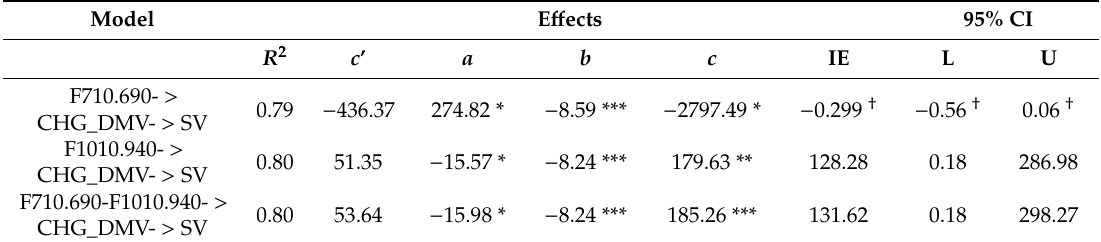
Table 2. Outcomes of mediation analyses from F710.690, F1010.940, and F710.690-F1010.940 to